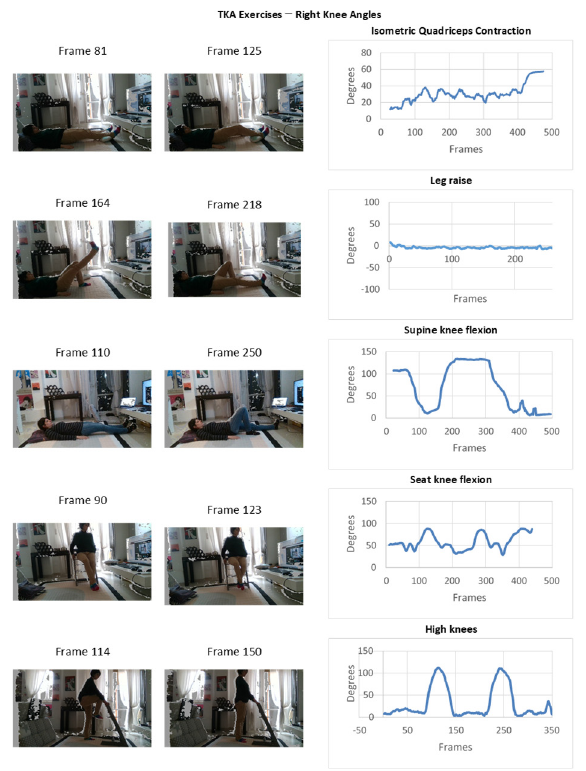
Figure 9. Experimental results of the monitoring in a domestic TKA post-operative environment.